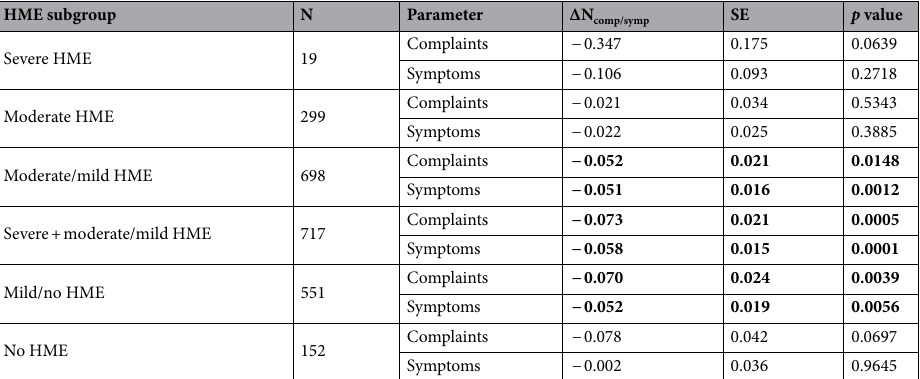
Table 3. Linear regression results of ΔN comp/symp as function of the difference in the total serum Mg level between Visit 1 and Visit 2 normalized by 0.1 mmol/L (ΔMg 0.1 ) in the severe, mild and no HME subgroups. Severe HME, serum Mg < 0.5 mmol/l; Moderate HME, serum Mg ≥ 0.5 mmol/L and < 0.66 mmol/L; Moderate/Mild HME, serum Mg ≥ 0.5 mmol/L and < 0.8 mmol/L; Mild/No HME, serum Mg ≥ 0.66 mmol/L and < 0.8 mmol/L; No HME, serum Mg ≥ 0.8 mmol/L. HME, hypomagnesemia; ΔN comp/symp, mean difference in the number of complaints, threatened miscarriage symptoms; ΔMg 0.1 , difference in the total serum Mg level between Visit 1 and Visit 2 normalized by 0.1 mmol/L; Mg magnesium; N number of women; SE standard error; p values reflect whether serum Mg level change is significantly and linearly related to lower number of complaints/symptoms. Significant p values (<0.05) are presented in